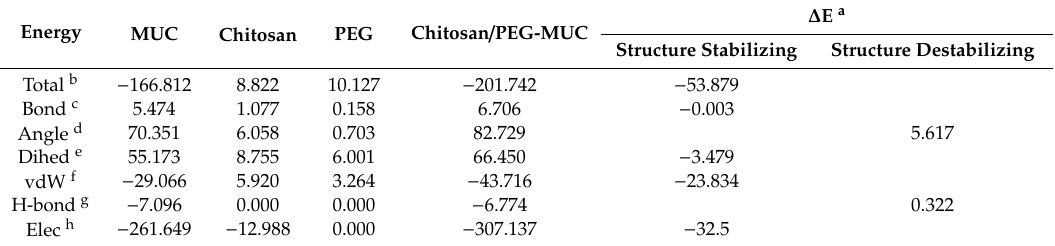
Figure 6. Representation of the geometrical preferences of ( A ) PLGA-MUC; ( B ) Chitosan / PEG-MUC after molecular mechanics simulations in vacuum [Colour code for elements: C = cyan; H = white; O = red; N = blue]. PLGA: tube rendering; MUC: stick rendering and yellow second. Table 3. Inherent energy attributes of chitosan / PEG-MUC conjugate calculated using static lattice atomistic simulations in